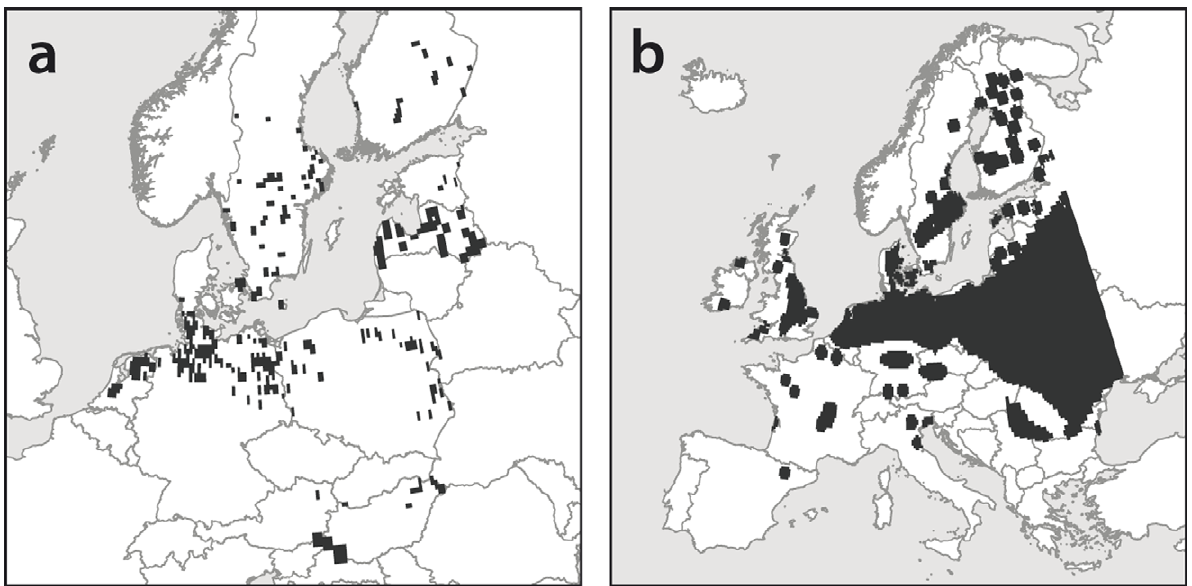
Figure 1. Current distribution of A) Aeshnaviridis and B) Stratiotesaloides in Europe [ 21,22 ] .